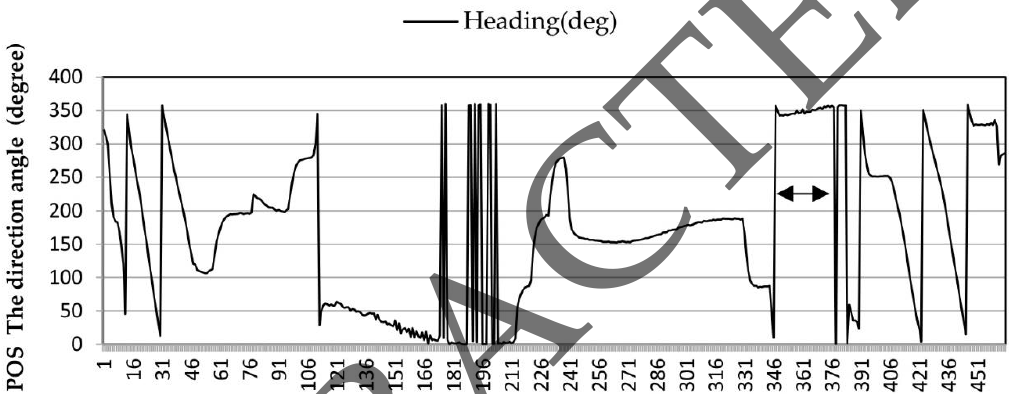
Figure 4. Direction angle variation in the POS system of an unmanned aerial vehicle (UAV) flight.